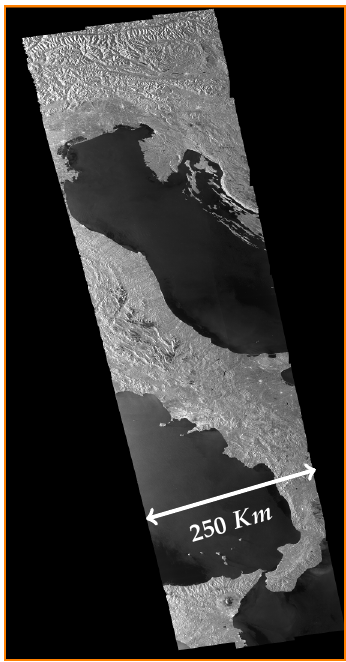
Figure 3. TOPS mode Sentinel-1 amplitude image of Italy; the 250 Km swath extension is